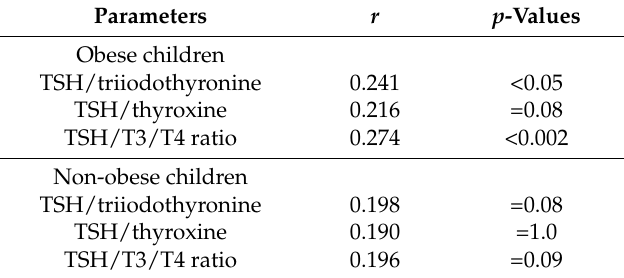
Table 5. Correlation of TSH with other thyroid hormone levels in obese and non-obese